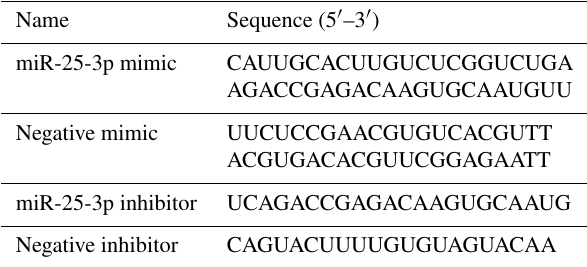
Table 1. RNA oligonucleotides in this article. Name Sequence (5 (cid:48) –3 (cid:48)